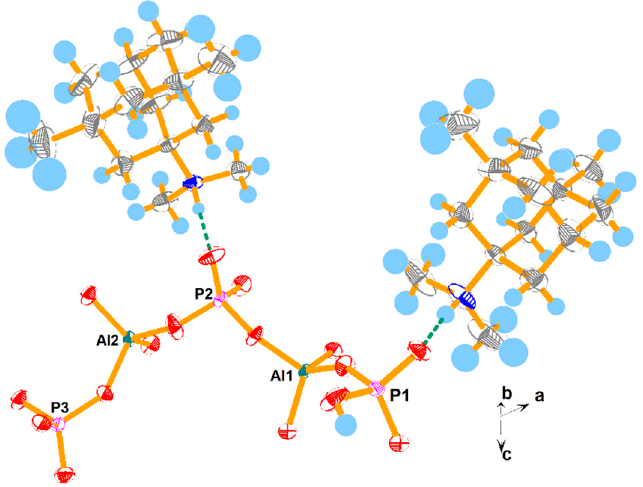
Figure 2. The asymmetric unit of SYSU-6, thermal ellipsoids at 50% probability. The hydrogen bonds are displayed as green dashed lines.